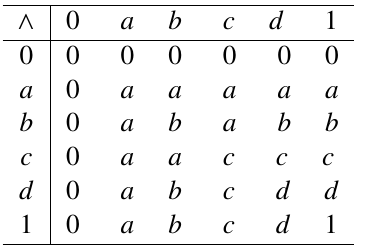
Table 1. the definition of the operator ∧ on L